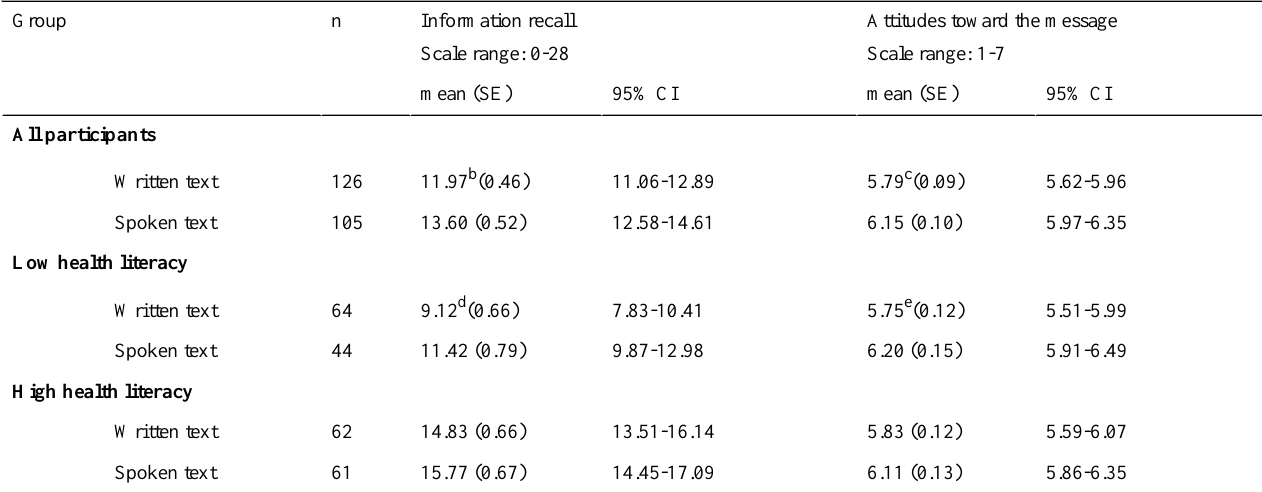
Table 2. Main effects of text modality on information recall and attitudes toward the message in people with low and high health literacy. a